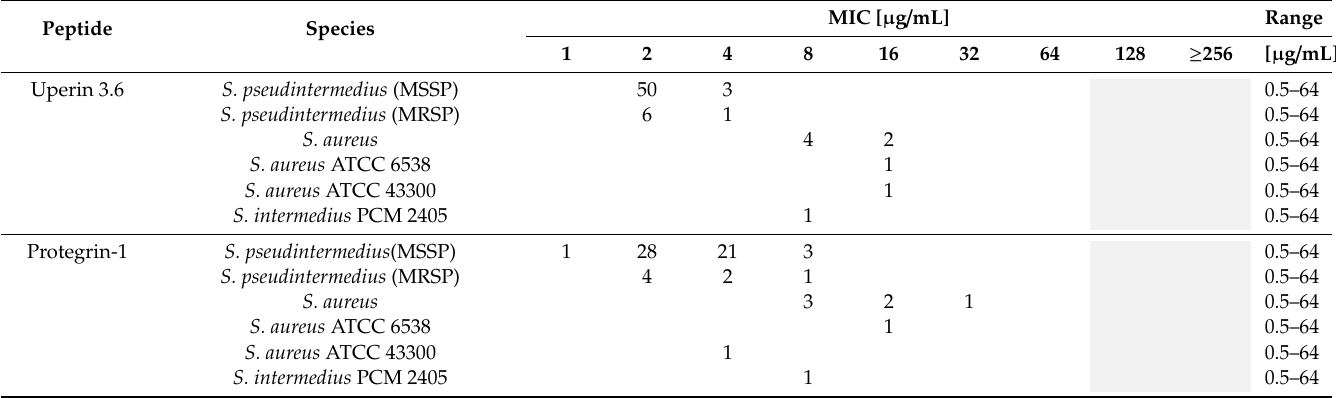
Table 3. Detailed comparison of MIC values of tested antimicrobial peptides against canine